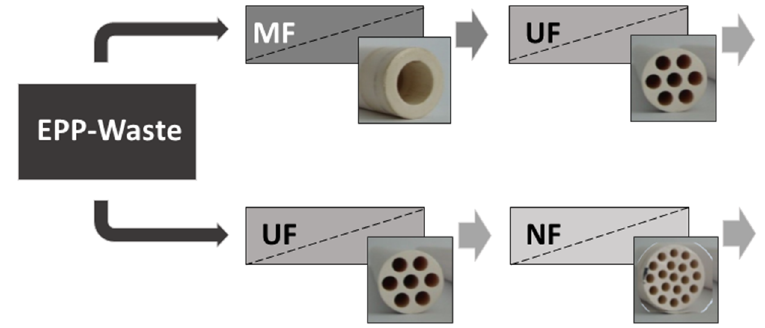
Figure 4. Overview of the two-stage membrane filtration configurations in this investigation.